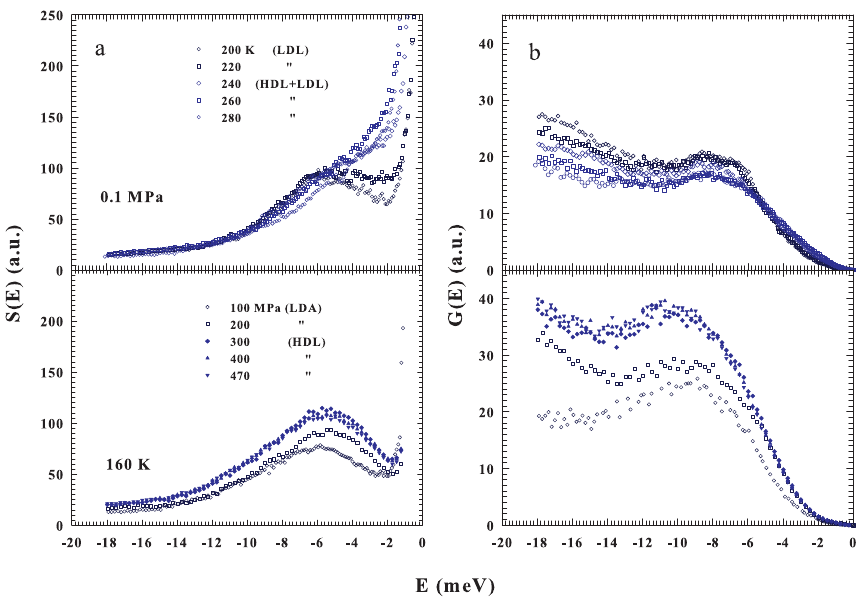
Figure 2. ( a ) Top panel: The INS incoherent spectra S ( E ) measured at the fixed pressure of 0.1 MPa ( T = 280,260,240, 220 and 200 K). Bottom panel: The S(E) spectra measured at the fixed temperature of 160 K ( P = 100,200,300,400 and 470 MPa). ( b ) The corresponding intermolecular density of states